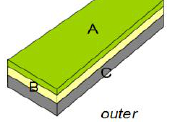
A B C O Figure 6. Simple example representing a landform in primal and dual space DualStructureRelation (1D-edges) linking pairs of DualStructure (nodes) in dual space (see Figure 6). The resulting dual graph represents a Node-Relation-Structure (NRS) as proposed by (Lee and Zlatanova, 2008). Besides the topological relationships the StructureBoundary represents the common 2D face shared by two adjacent solids, e.g. the change of soil within the landform. Equal to Becker et al. (2008; 2009) an unknown or not needed boundary to adjacent structures can be represented in primal space as a shared Boundary with the outer environment – o uter . In dual space a DualStructureRelation is integrated into the overall graph structure (cf. Figure